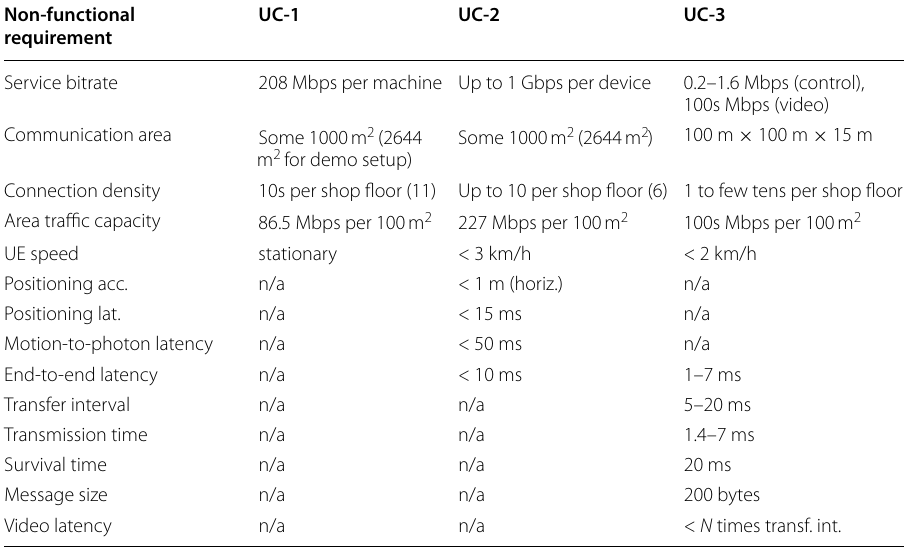
Table 1 Non‑functional requirements